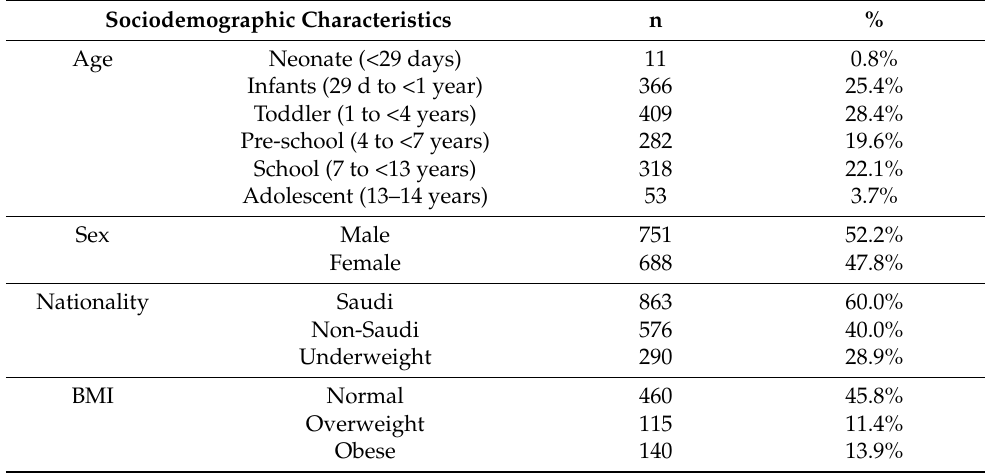
Table 1. Sociodemographic characteristics of pediatric visits to PHC center during